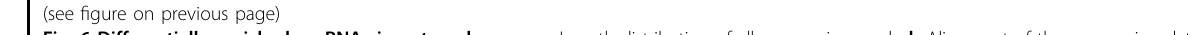
Fig. 6 Differentially enriched sncRNAs in paternal sperm. a Length distribution of all sequencing reads. b Alignment of the sequencing data. anno_MG: matched to the reference genome and annotated; unanno-MG: matched to the reference genome but not annotated; anno-UMG: unmatched to the reference genome but annotated; unanno-UMG: unmatched to the reference genome and not annotated. c Distribution of the reads in annotated RNAs. d Heatmap of differentially enriched sncRNA subclasses. e Composition of the differentially enriched sncRNA subclasses. f Sources of differentially enriched sncRNA sequence types. g Length distribution of the 18S rRNA-derived rsRNA sequences in paternal sperm. h Length distribution of the 4.5S rRNA-derived rsRNA sequences in paternal sperm. i The main sources of the differentially enriched tsRNA sequences. j Length distribution of the mt (mitochondrial)-HisGTG-derived sequences. k The main sources of the differentially enriched miRNA sequences. l Length distribution of the miR- let-7-derived sequences. m Expression levels of the miRNAs related to Rhobtb3 gene. n Expression levels of the miRNAs related to Oprm1 gene. o Differences in the numbers of the aligned sncRNA sequences between heritable and un-heritable